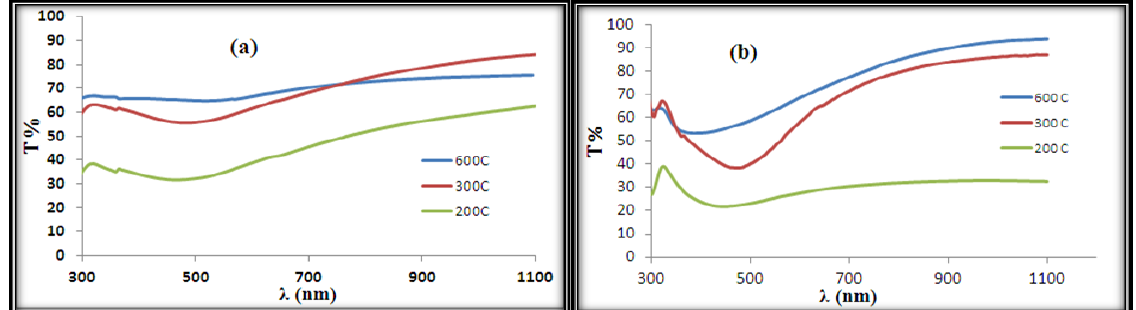
Cu O thin films sintered at 2 2 4